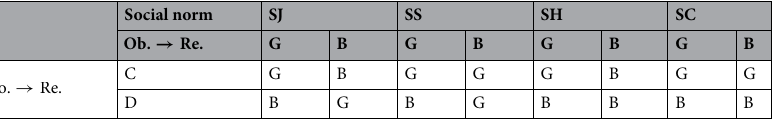
Table 1. How observers with four social norms, SJ , SS , SH , and SC , assign a reputation to a donor when an error in assessment does not occur. Rows indicate whether the donor takes cooperation (C) or defection (D) with a recipient. Columns indicate whether the recipient’s reputation is good (G) or bad (B) in the eyes of the observer.